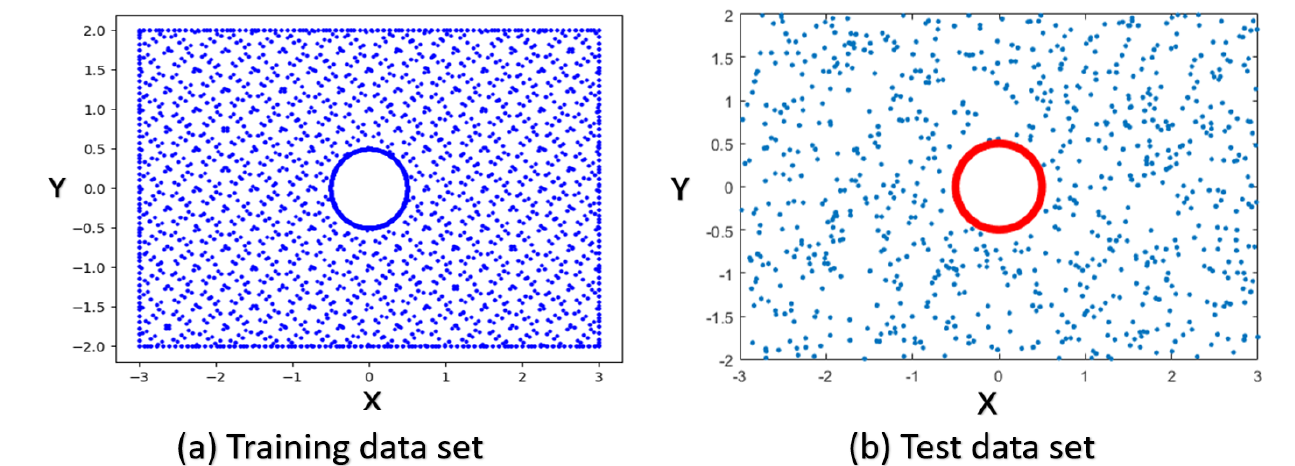
Figure 5. Randomly sampled data points across the computational domain for training ( a ) and test purpose ( b